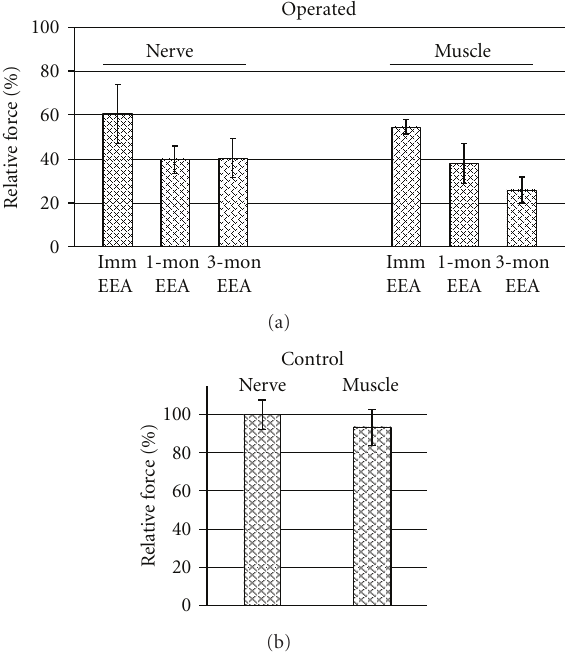
Figure 8: Average maximal muscle force of the SM muscle in di ff erent experimental conditions. (a) Shows maximal muscle force recorded from the operated SM muscles with immediate nerve repair after nerve transection (Imm EEA), with 1-month delay nerve repair (1-mon EEA) and with 3-month delay nerve repair (3- mon EEA). Data were normalized through dividing the maximal muscle force from the operated SM muscle by the maximal muscle force from the control SM muscle. Maximal muscle force produced by nerve stimulation is shown at the left side of the graph and by direct muscle stimulation at the right side of the graph. (b) Illustrates a comparison between the maximal muscle force evoked through nerve stimulation and through direct muscle stimulation of the control muscle (the intact muscle on the contralateral side). Muscle force (average from all three EEA groups) is presented as a percentage of maximal muscle force produced by nerve